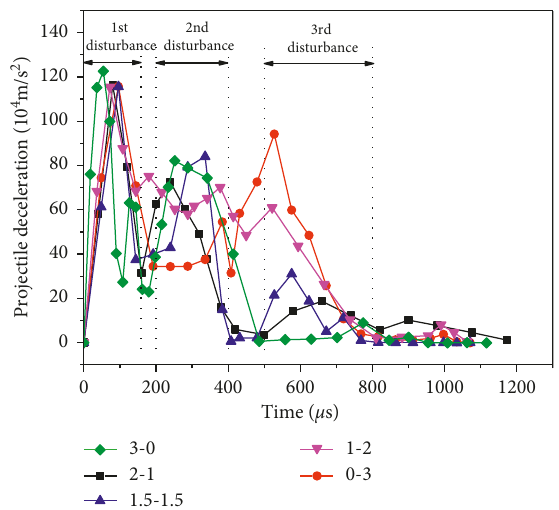
Figure 11: Deceleration-time curves of a projectile with different steel liner